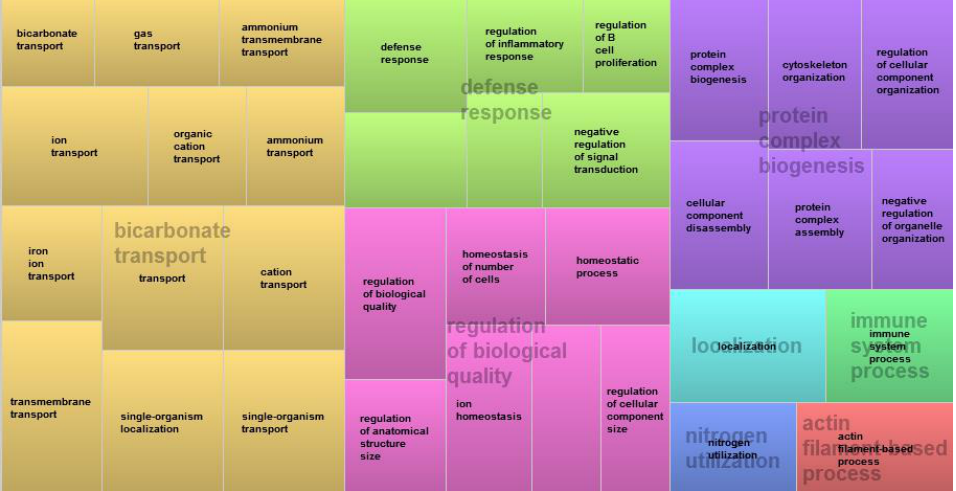
Figure 1. Main biological process involved with FHS considering the DE genes shared between articular cartilage and femoral growth plate using the REVIGO tool.